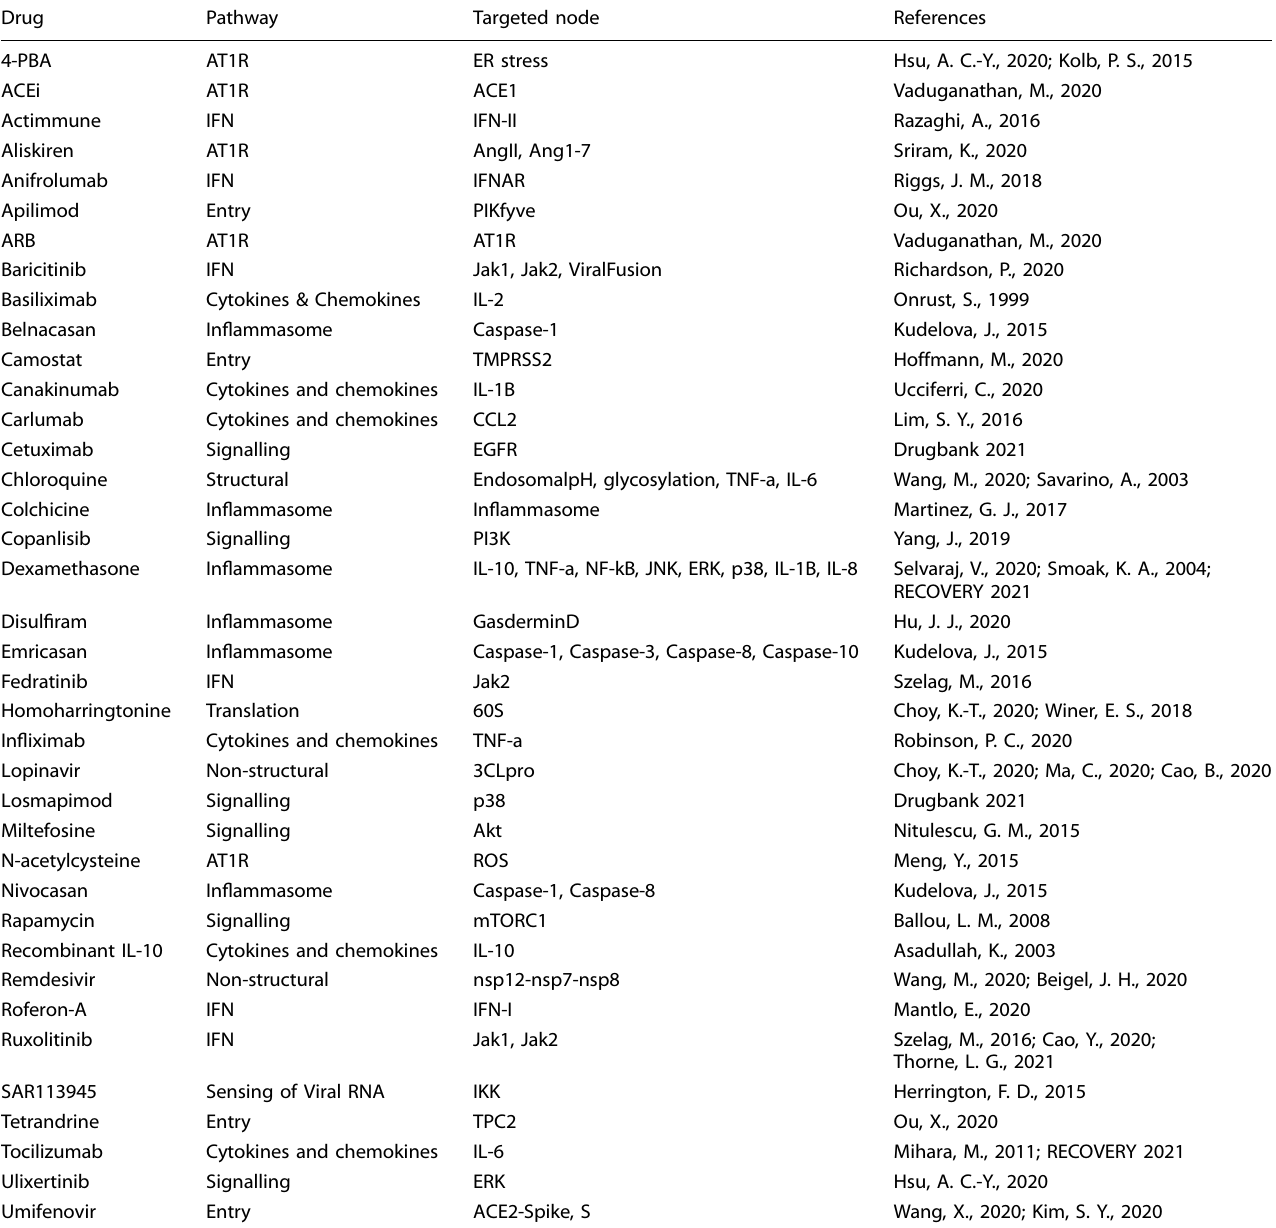
The network model was used to evaluate the best single and combinations of 38 drugs, either clinically approved or in phase II/III trials at the time of writing. Drugs that had not passed phase II/III clinical trials at the time of writing are included in Supplementary Table 5 and the network model predictions for these drugs are shown in Supplementary Figs. 8,